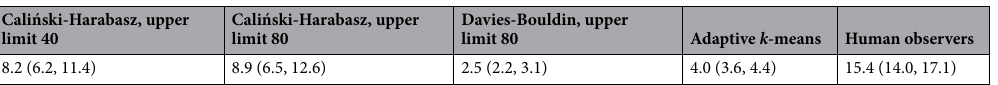
Table 2. Estimated optimum numbers of clusters, averaged over 20 images, according to three methods, and different initial values. Data for human observers are included for comparison. Estimated 95% BCa confidence limits 36 are shown in parentheses, based on 1000 bootstrap